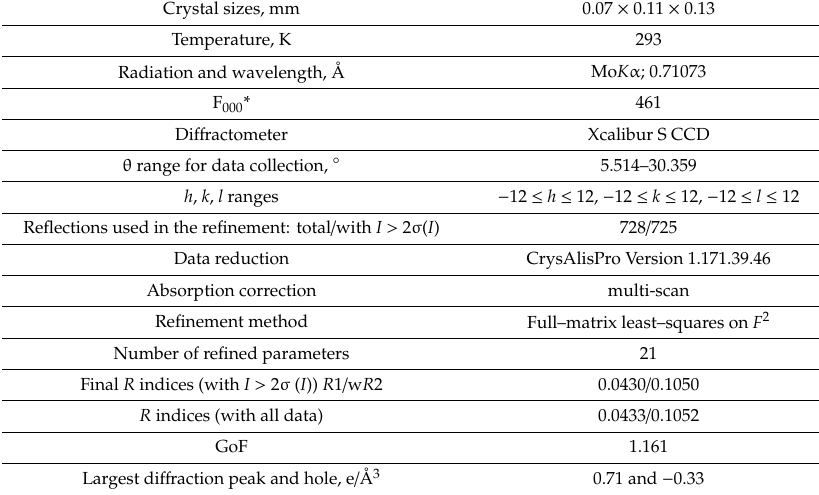
Table 2. Crystal data, data collection information and structure refinement details for sample 9.